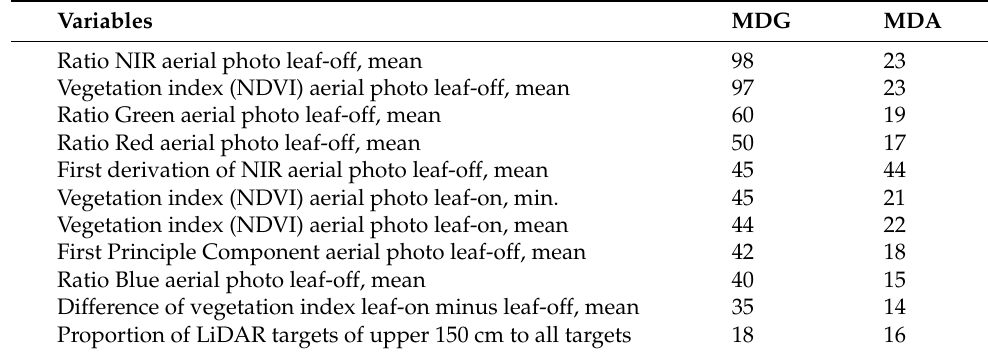
Table 5. List of variables implemented in the final model in descending order of Mean Decrease Gini (MDG) value, Mean Decrease Accuracy (MDA) values are indicated for comparison.